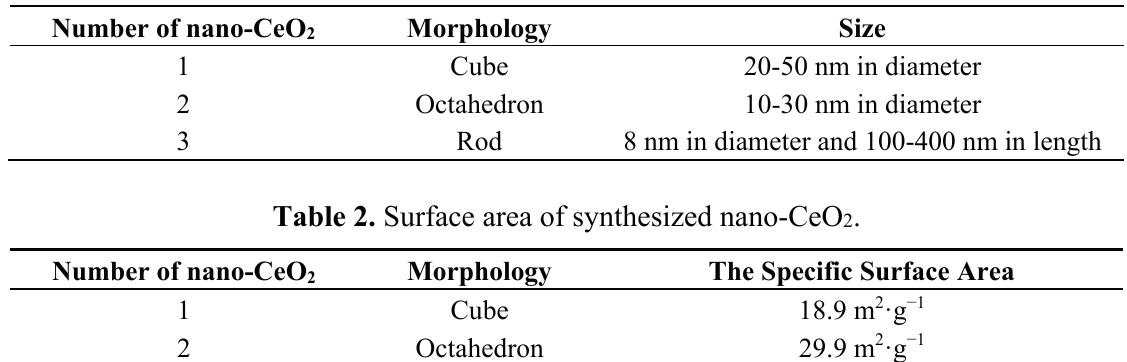
Figure 2. The TEM images of nano-CeO 2 synthesized by hydrothermal processing. ( A ) Cubes; ( B ) octahedrons; ( C ) rods. Table 1. Three kinds of nano-CeO 2 with different morphologies and sizes.